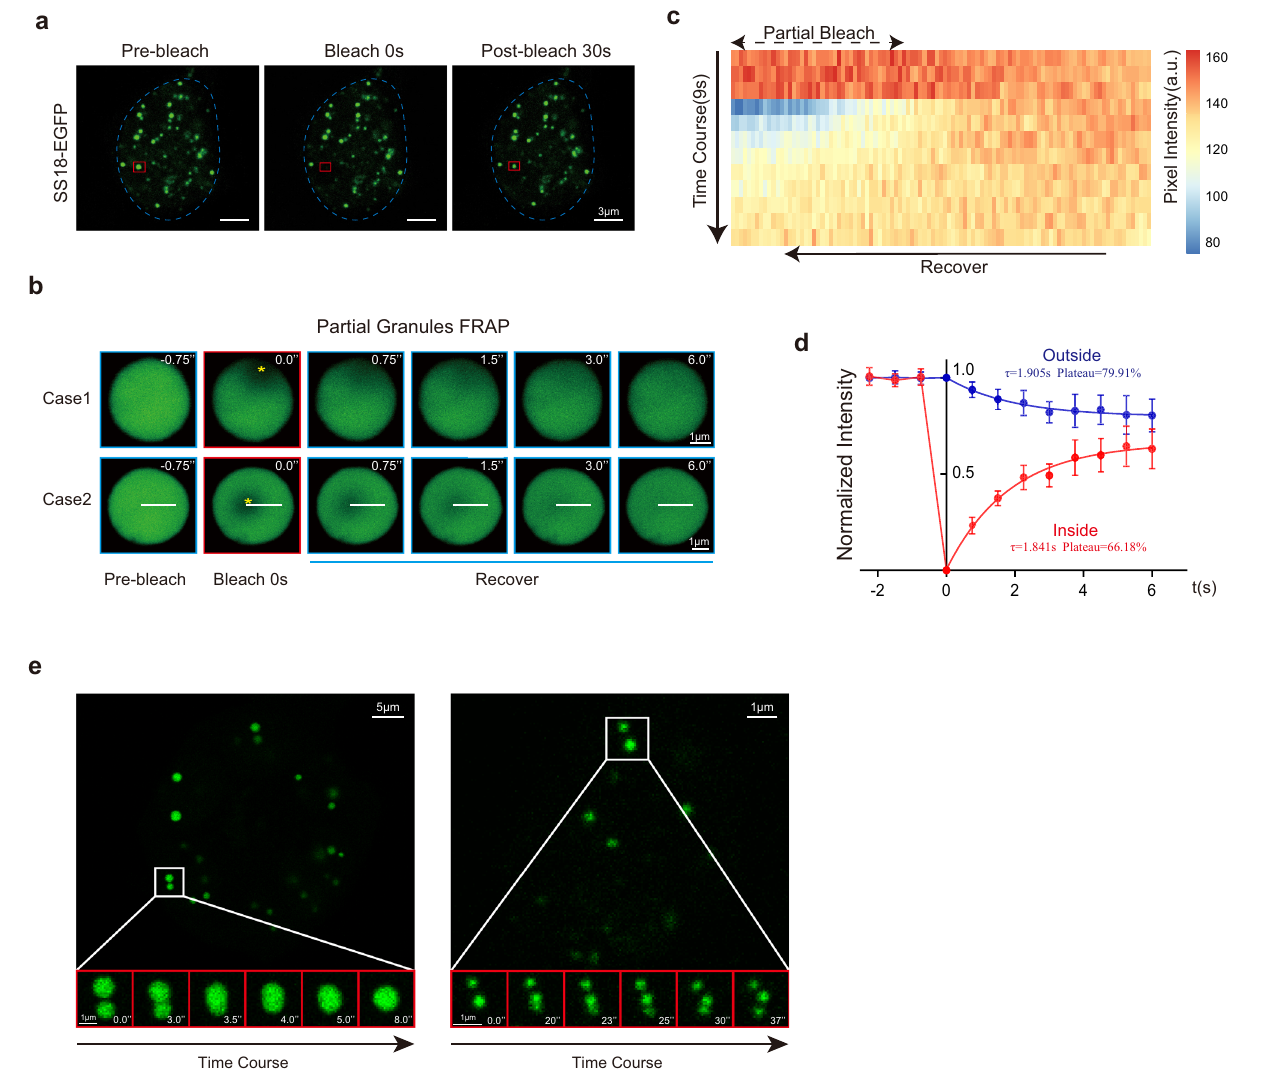
Fig. 3 SS18 forms condensates. a Representative images of FRAP experiments with lentiviral SS18-EGFP expressed in mESCs. The droplet undergone bleaching was indicated in the red box. The blue dotted line represents the nuclear boundary. Scale bars,3 μ m. laser intensity 2.5%, detector gain 500 V, background subtraction treatment. Seven condensates from two independent experiments. b Time course microscopy images of fl uorescence recovery in SS18-EGFP condensates after partial photobleaching at the edge (case 1) and middle (case 2). SS18-EGFP was expressed by transient transfection in 293 cells to obtain the large enough condensates. The bleached regions were marked by yellow asterisks. Scale bars, 1 μ m. laser intensity 2.5%, detector gain 500 V, background subtraction treatment. Eight condensates from two independent experiments. c Kymography for the time course of pixel intensity along the white line in the condensate of case 2 in ( b ). The intensity recovered in the bleached region inside the condensate as the unbleached part decreased. 0 was the bleached time point. τ (inside) = 1.841 s, τ (outside) = 1.905 s; Plateau(inside) = 66.18%, Plateau(outside) = 79.91%, diffusion coef fi cient on